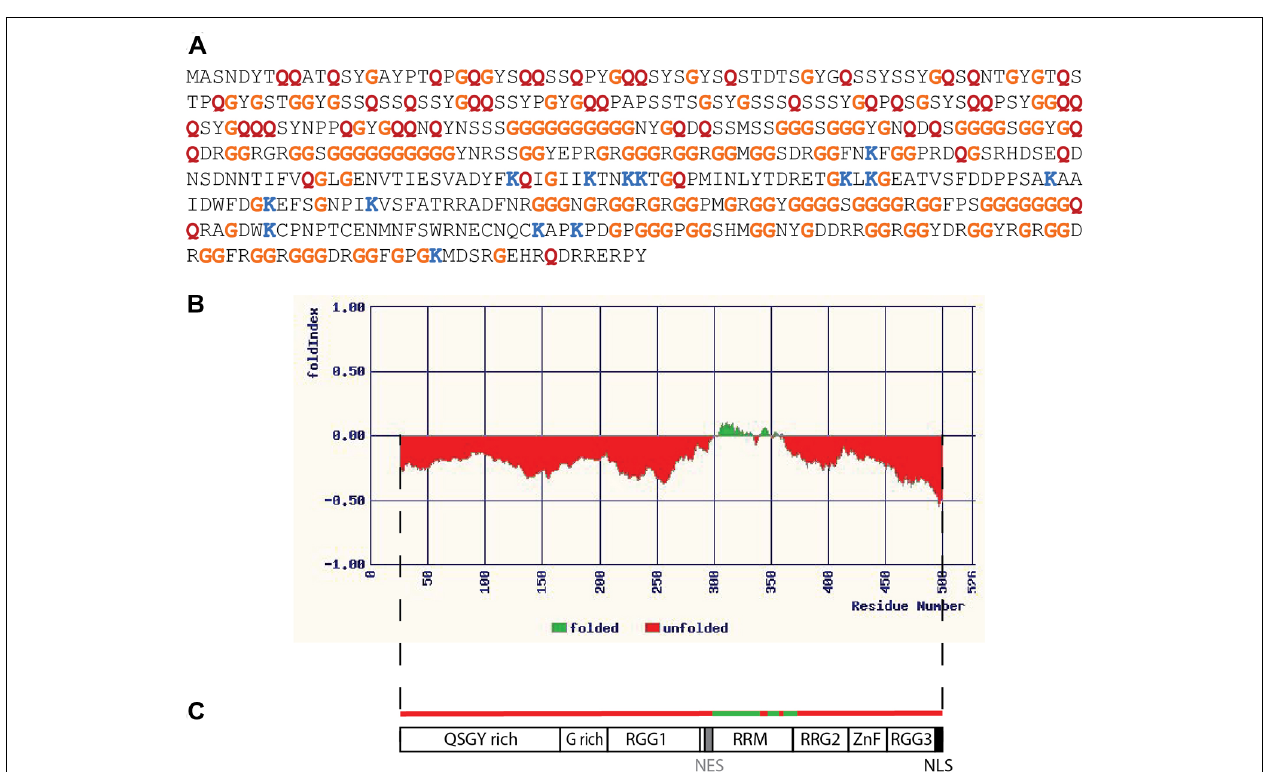
the FUS protein as predicted by the FoldIndex algorithm (available at http://bip.weizmann.ac.il/fldbin/findex). Only a central portion of approximately 50 residues (indicated in green) is predicted to have a stably folded structure. (C) Domain organization of FUS.The folded domain corresponds to a region with nucleic acid binding properties (designated the RRM, or RNA recognition motif, though this region may also bind DNA).There are regions rich in the amino acids indicated by their single letter codes, as well as domains rich in the simple repeat arginine, glycine, glycine (RGG). ZnF indicates a putative zinc finger motif (Iko etal., 2004). NES represents a region with nuclear export activity, while NLS represents the nuclear localization signal.This schematic is adapted from a similar figure in the review of Lagier-Tourenne and Cleveland